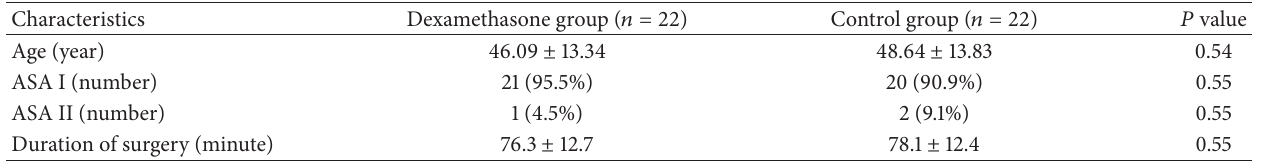
Table 1: Demographic parameters in two groups.